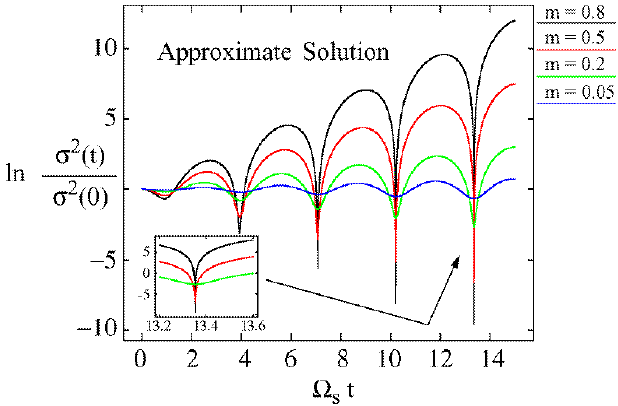
FIG. 1. (Color) .Evolution of bunch length with time: Eq. (18).